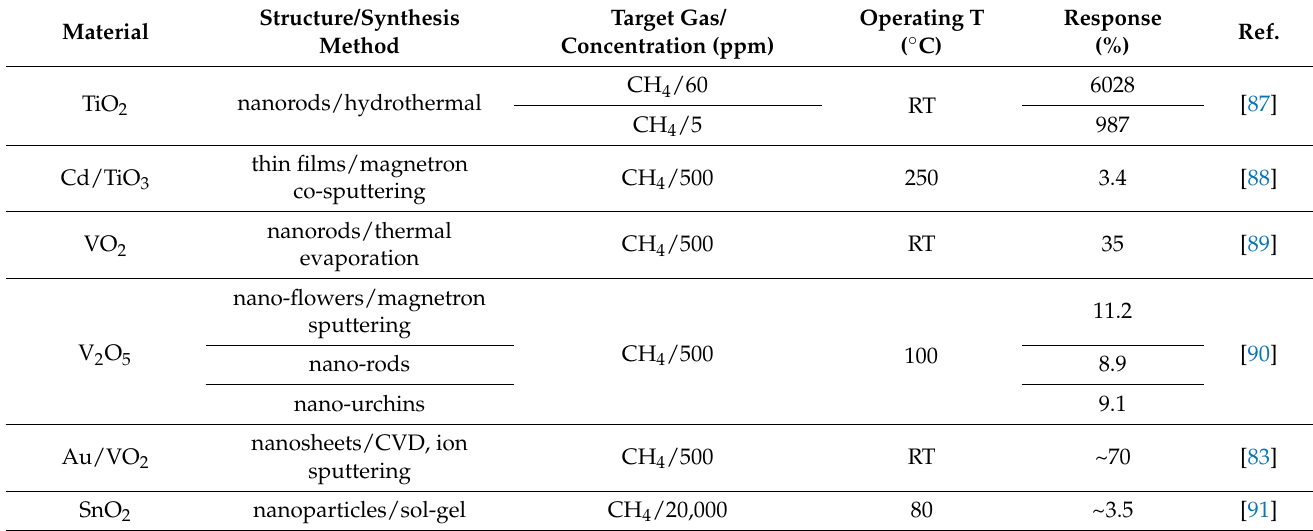
Table 5. A brief summary of MOX-based CH 4 gas